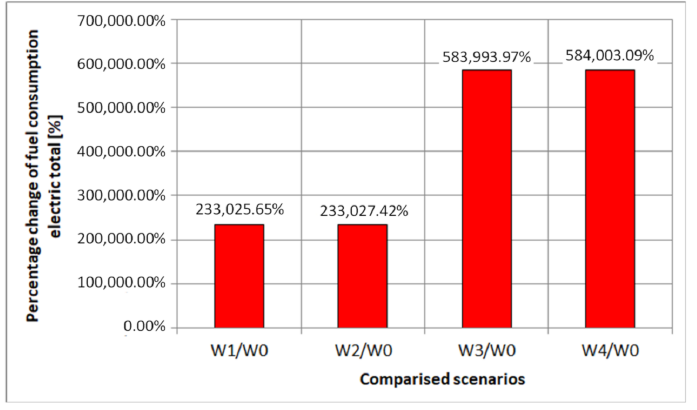
Figure 23. Values of the ratio between W0 and scenarios W1–W4 for fuel consumption electric [MJ]—analysis for the whole city.